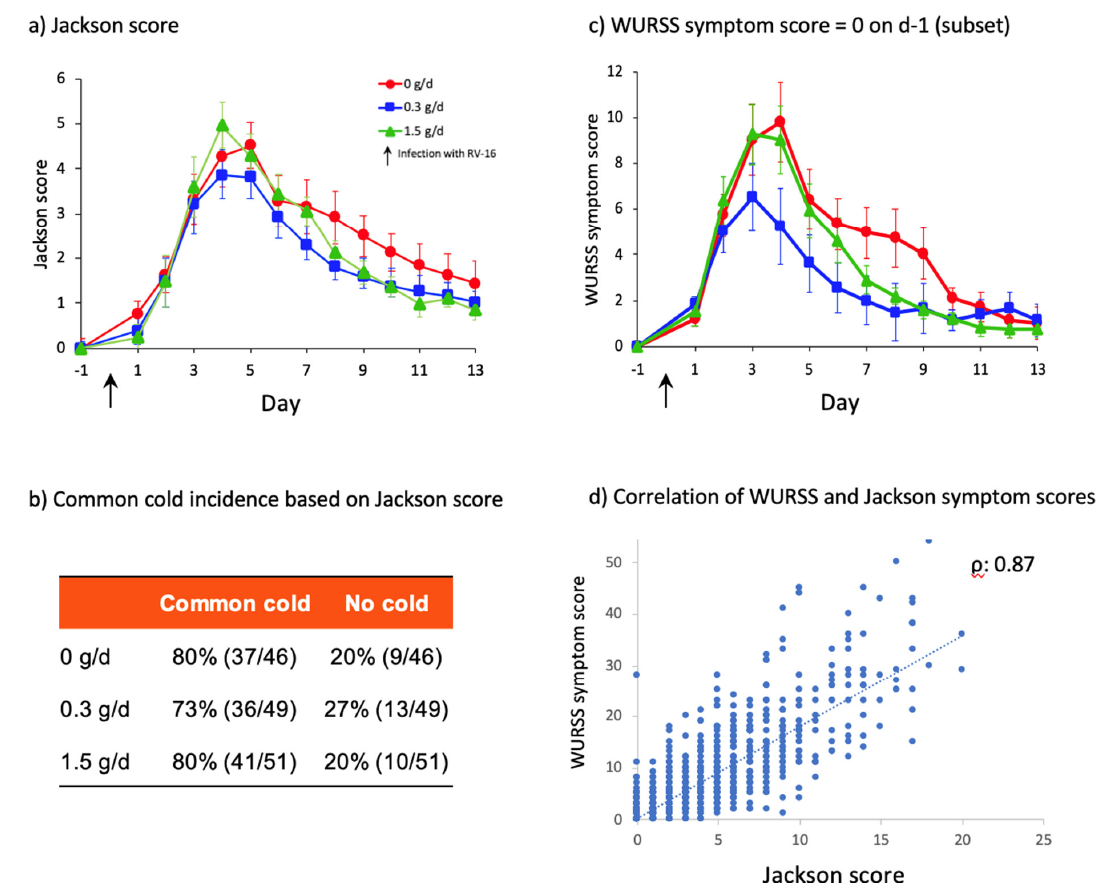
Figure 3. ( a ) Perceived symptoms following infection with RV16. Jackson score in full ITT popula- tion ( n = 146), the GEE model showed a parabolic association in time as well as dose of cRG-I ( p < 0.0001), ( b ) Common cold incidence based on established criteria for Jackson score (score at least 2 on at least two consecutive days, ITT population n = 146) no significant differences, ( c ) Subset with WURSS symptom score = 0 on day (d-1) prior to infection ( n = 87) the GEE model showed a parabolic association in time as well as dose of cRG-I ( p < 0.0001), ( d ) Correlation of WURSS-21 and Jackson symptom scores, analyzed using Spearman’s rank-correlation, coefficient ρ : 0.87, p < 0.0001, linear regression analysis indicates a positive association between the data of both scores.